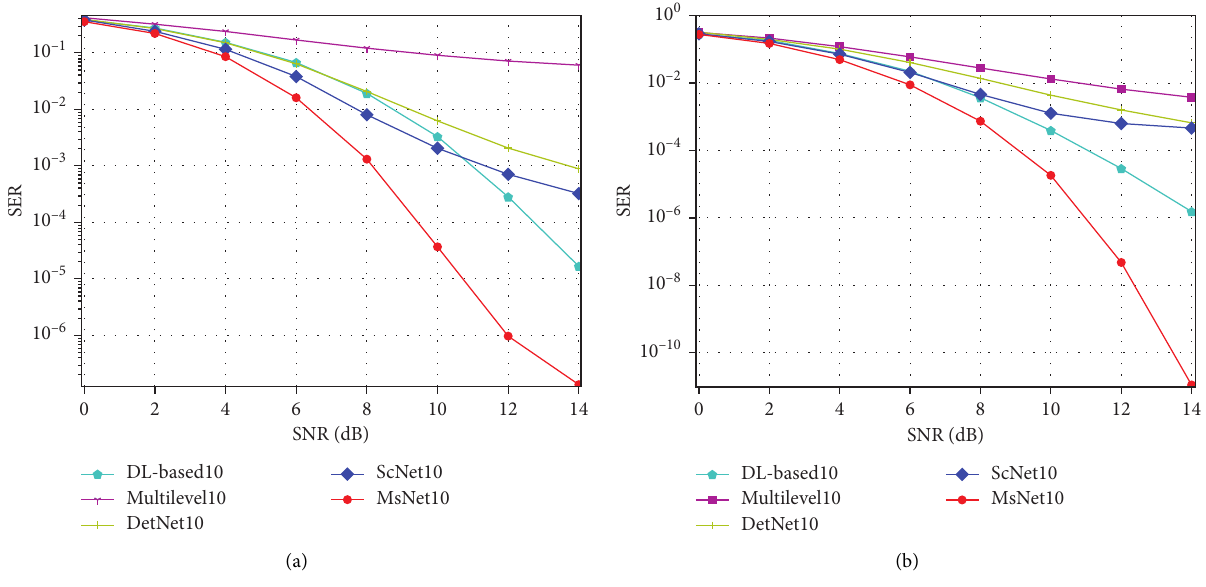
Figure 8: 16-QAM SER comparison of various detectors for (a) M � 32 and N � 64 and (b) M � 32 and N �